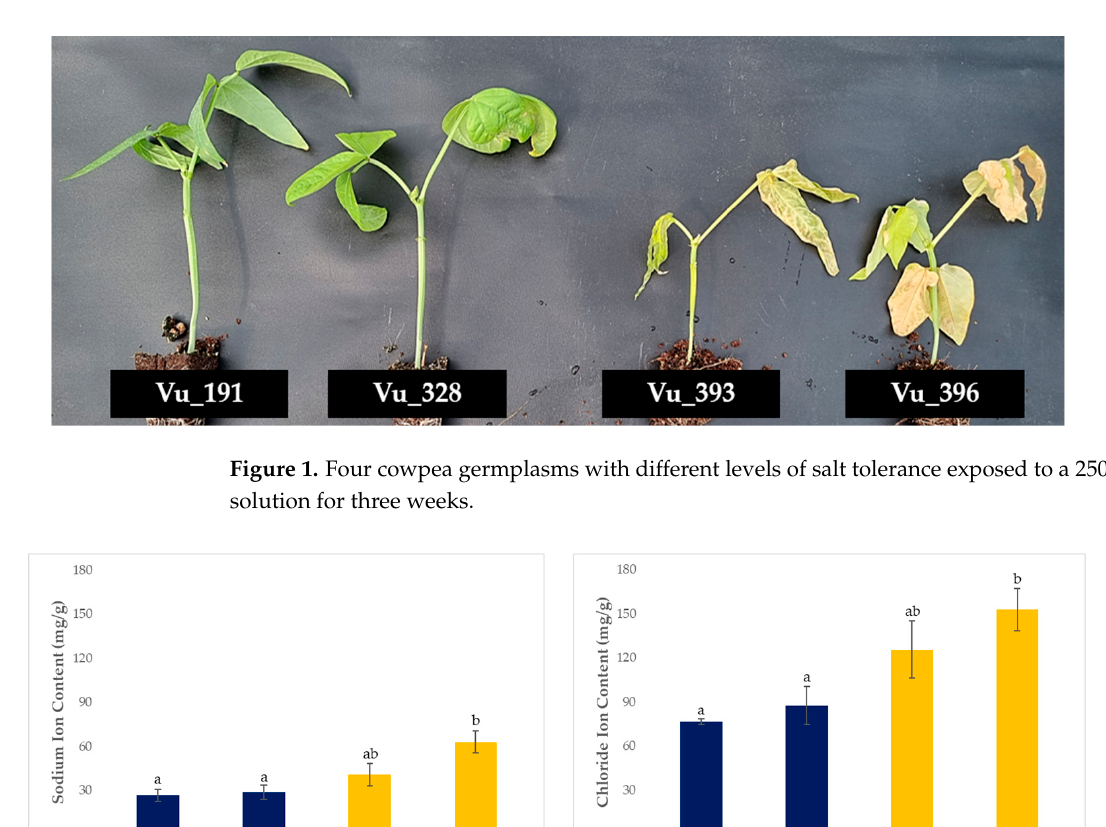
Figure 2. Ion accumulation for four cowpea germplasms exposed to 250 mM NaCl for three weeks: ( a ) sodium ions and ( b ) chloride ions. Different lowercase letters indicate statistically significant differences (LSD tests; p < 0.05). The error bars represent the standard deviation for five biological replicates.